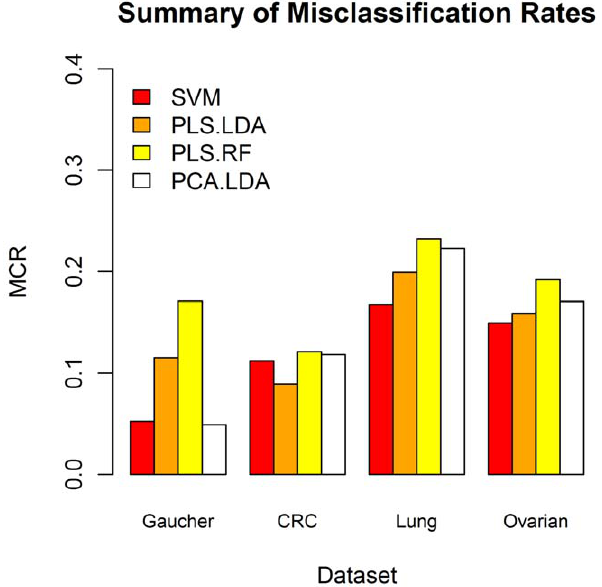
Table 2. SVM tuning results.